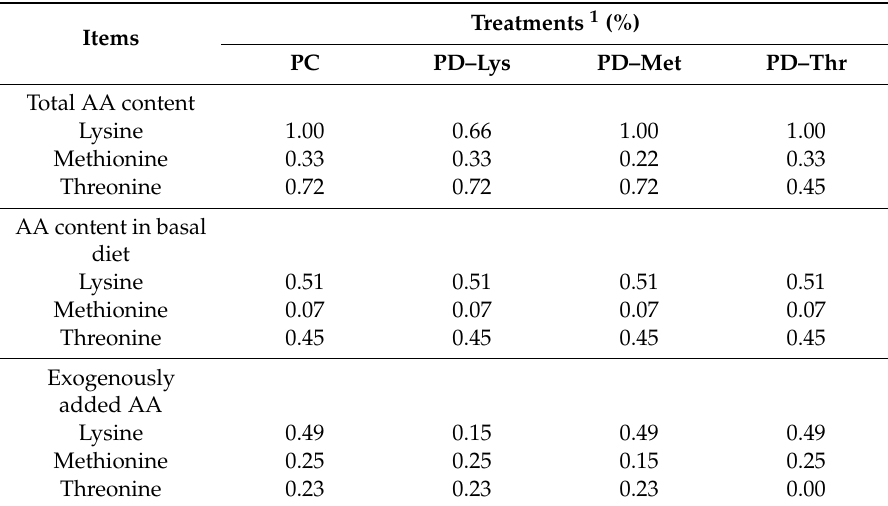
Table 2. Amino acid (AA) levels of TMRs (dry matter